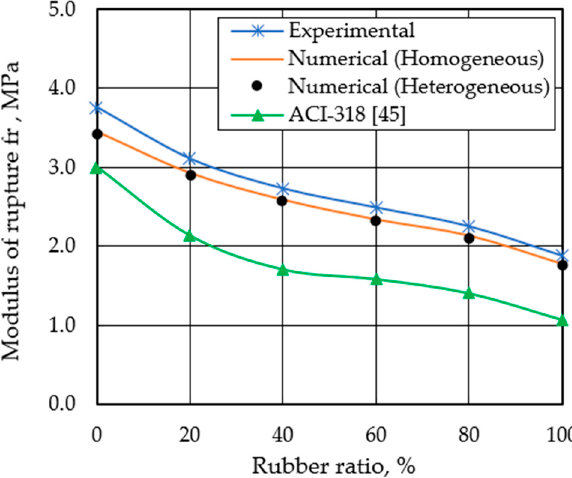
Figure 10. Modulus of rupture versus rubber content relationships for all beam